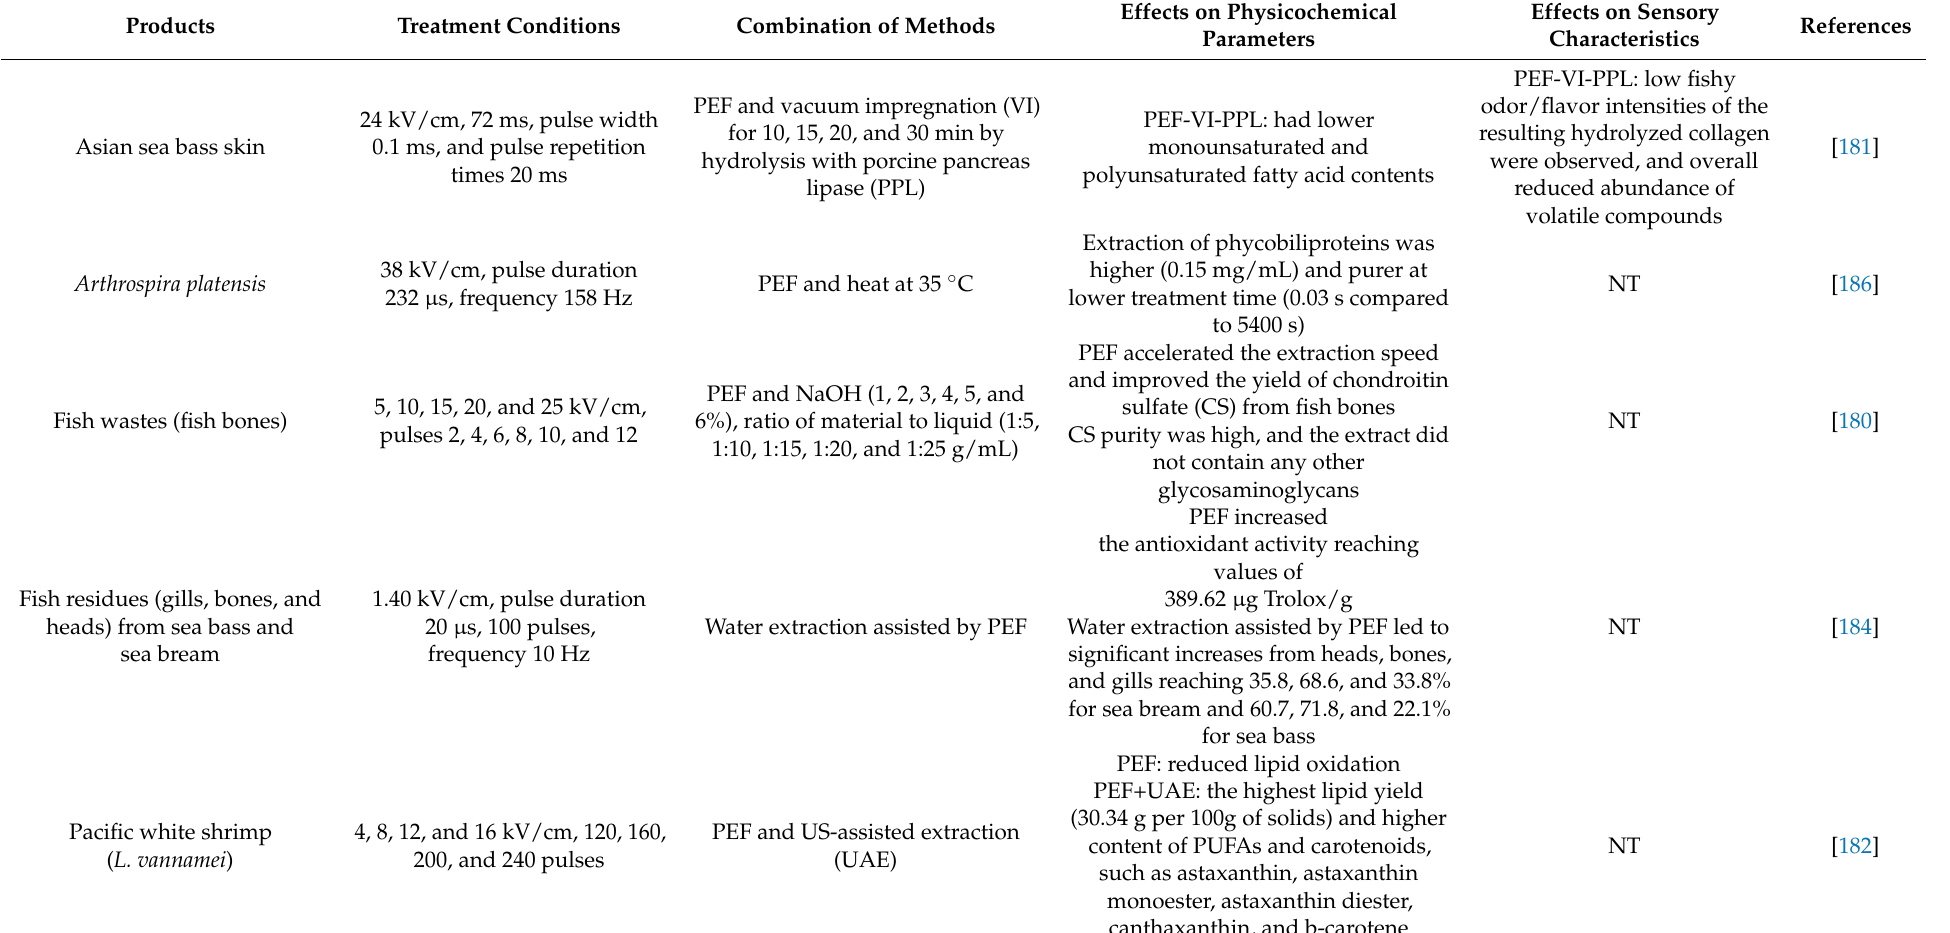
Table 3. Studies on the application of pulsed electric fields (PEF) treatment on fish and seafood